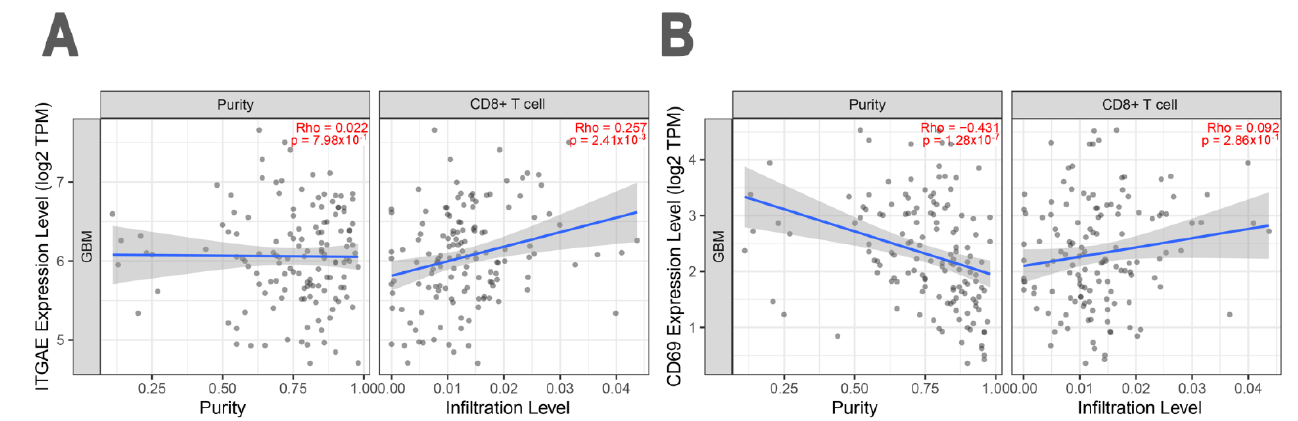
Figure 5. Spearman correlation test from Using EPIC on a cohort of n = 153 patients with GBM. Scatter plot showing the positive correlation between the abundance of CD8 + TILs and the expression of ( A ) ITGAE and ( B ) CD69 , genes. In ( A , B ), the left panel indicates tumor purity, and the right panel indicates T cells infiltrate. Tumor purity Adjustment (Purity) and immune infiltration are used for negatively correlated.